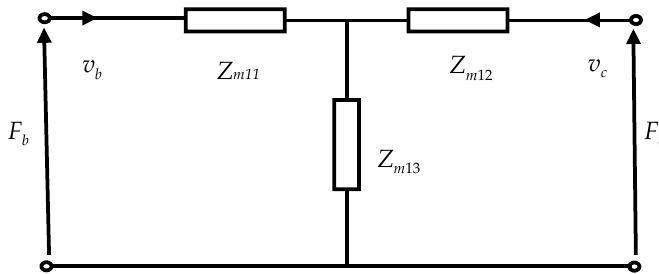
Figure 3. Electromechanical equivalent circuit of the radial vibration of the outer metal tube.